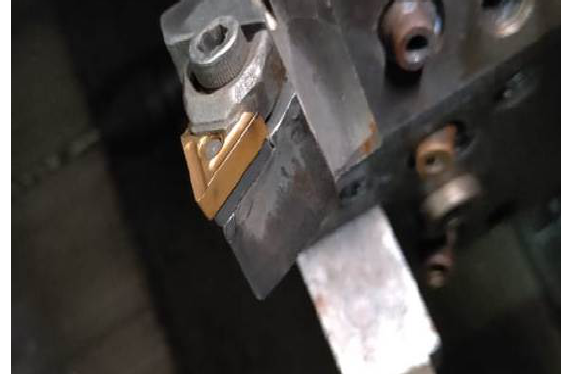
Figure 4. Cutting insert used.